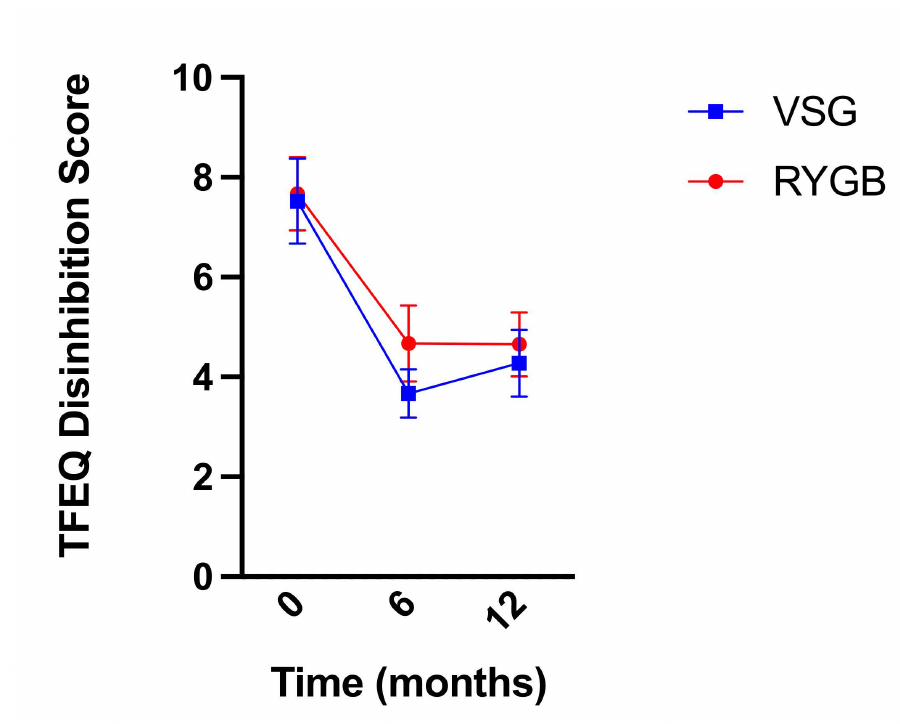
Figure 9. Mean ± SEM self-reported scores on the TFEQ disinhibition scale at baseline, six months, and one year following RYGB (red circles) and VSG (blue